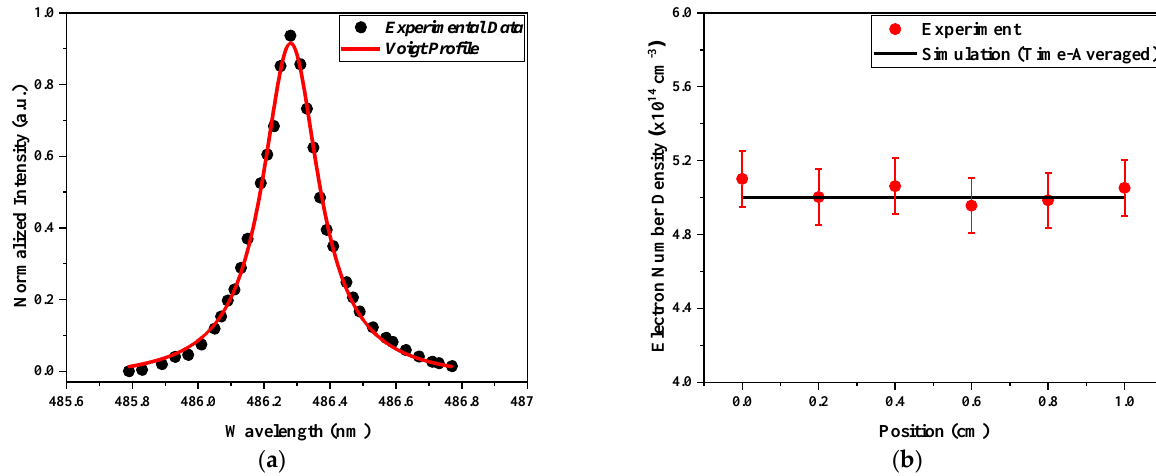
Figure 8. ( a ) Detected H β emission line with its fitting to a Voigt profile. ( b ) Variations of electron density as a function of position at the AC voltage of 22 kV and 1 cm distance between electrodes.